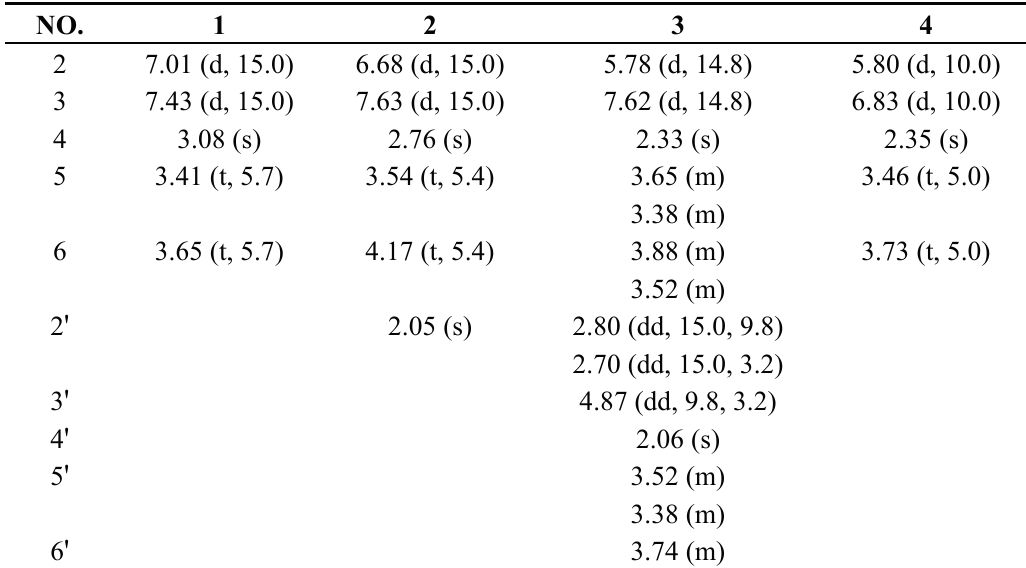
Table 1. 1 H-NMR spectroscopic data of compounds 1 – 4 ( 1 and 2 in CD 3 OD, 3 and 4 in CDCl 3 , 400